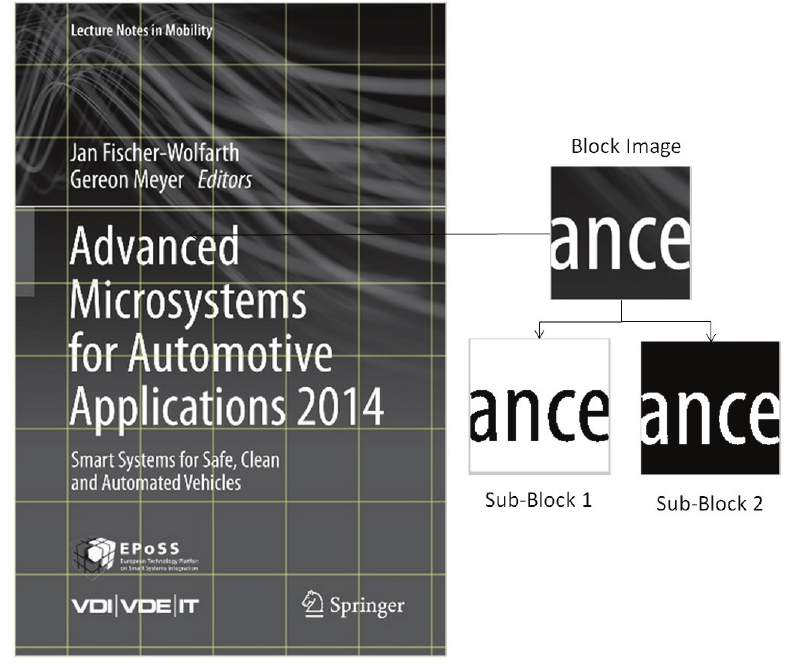
Figure 2: Example of Block and Sub-Block images in our